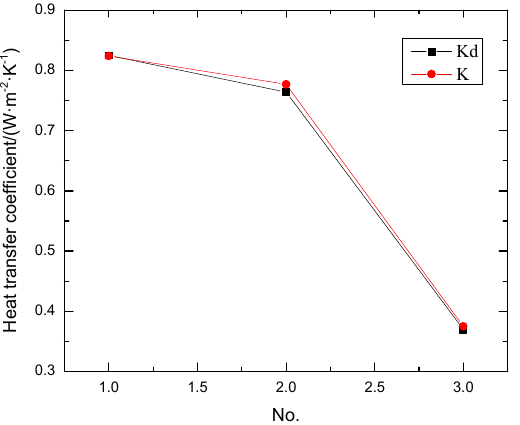
Figure 3. Results comparison of theoretical calculation method and the derived calculation method.